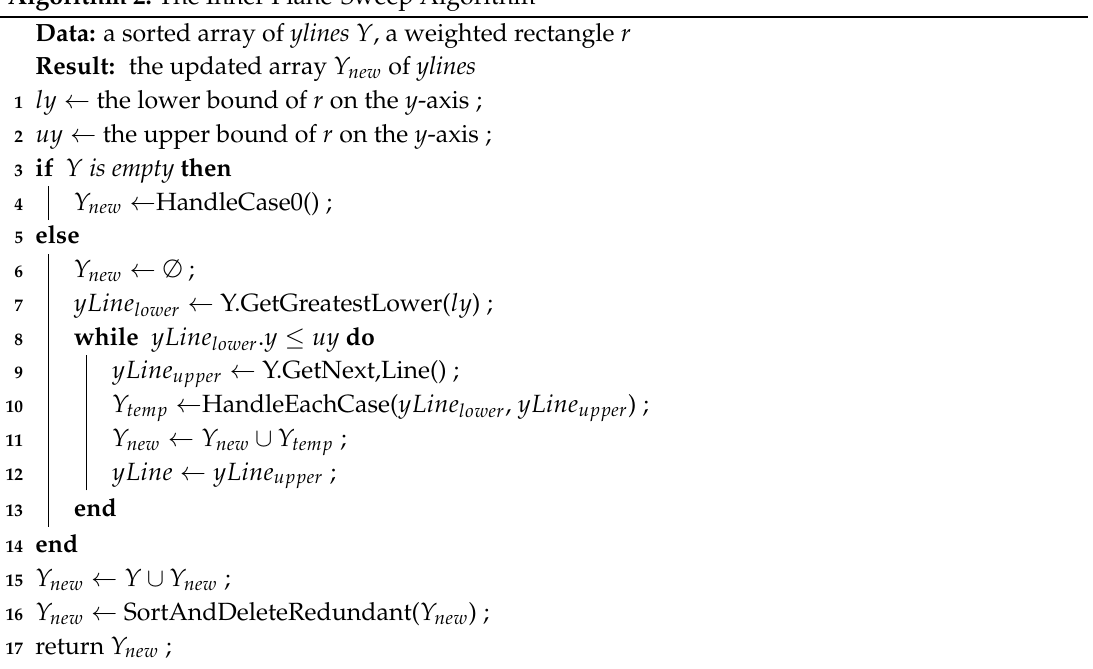
Algorithm 2: The Inner Plane-Sweep Algorithm Data: a sorted array of ylines Y , a weighted rectangle